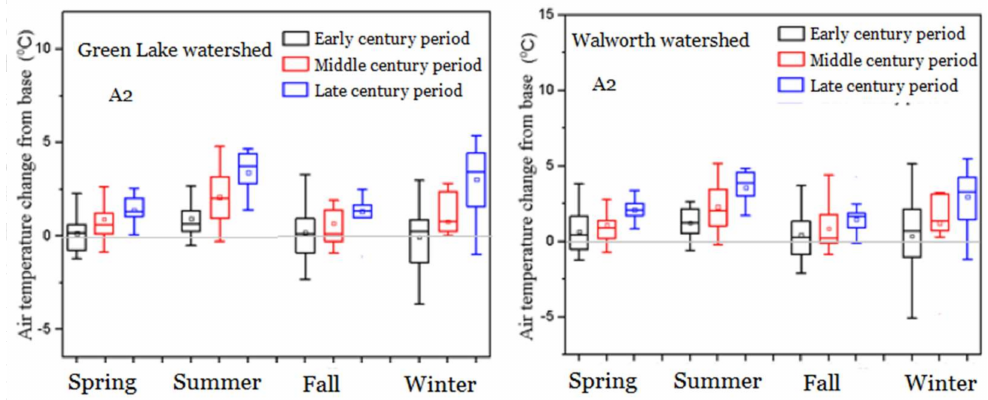
Figure 4. Seasonal changes of air temperature at the Green Lake watershed and Walworth watershed under the A2 scenarios. ( left ): Green Lake watershed, ( right ): Walworth